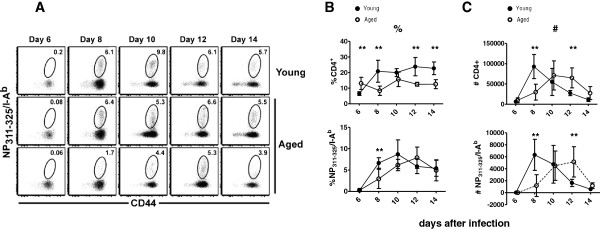
The appearance of antigen-specific CD4 T cells in the lung airways after primary infection with influenza virus is delayed in aged mice. Young and aged mice were infected with 3,000 EID50 ×-31 influenza virus and the bronchoalveolar lavage (BAL) was assessed at 6, 8, 10, 12 and 14 days post infection for CD4 T cells and Flu NP-specific CD4 T cells. Panel A shows representative NP311–325/IAb tetramer staining. All data are gated on CD4 T cells. The number in the upper right of each plot indicates the per cent of tetramer+ cells among the activated (CD44high) CD4 T cells. Panel B shows the percent of CD4 T cells and the percent of NP311–325/IAb-specific cells in the BAL at the indicated timepoints after infection. Panel C shows the absolute number of CD4 T cells and NP311–325/IAb-specific cells in the BAL at the indicated timepoints after infection. The mean ± SD are shown and the data are representative of 2 independent experiments with 5–8 mice per time point. Data were analyzed by unpaired t-test (**p < 0.005).